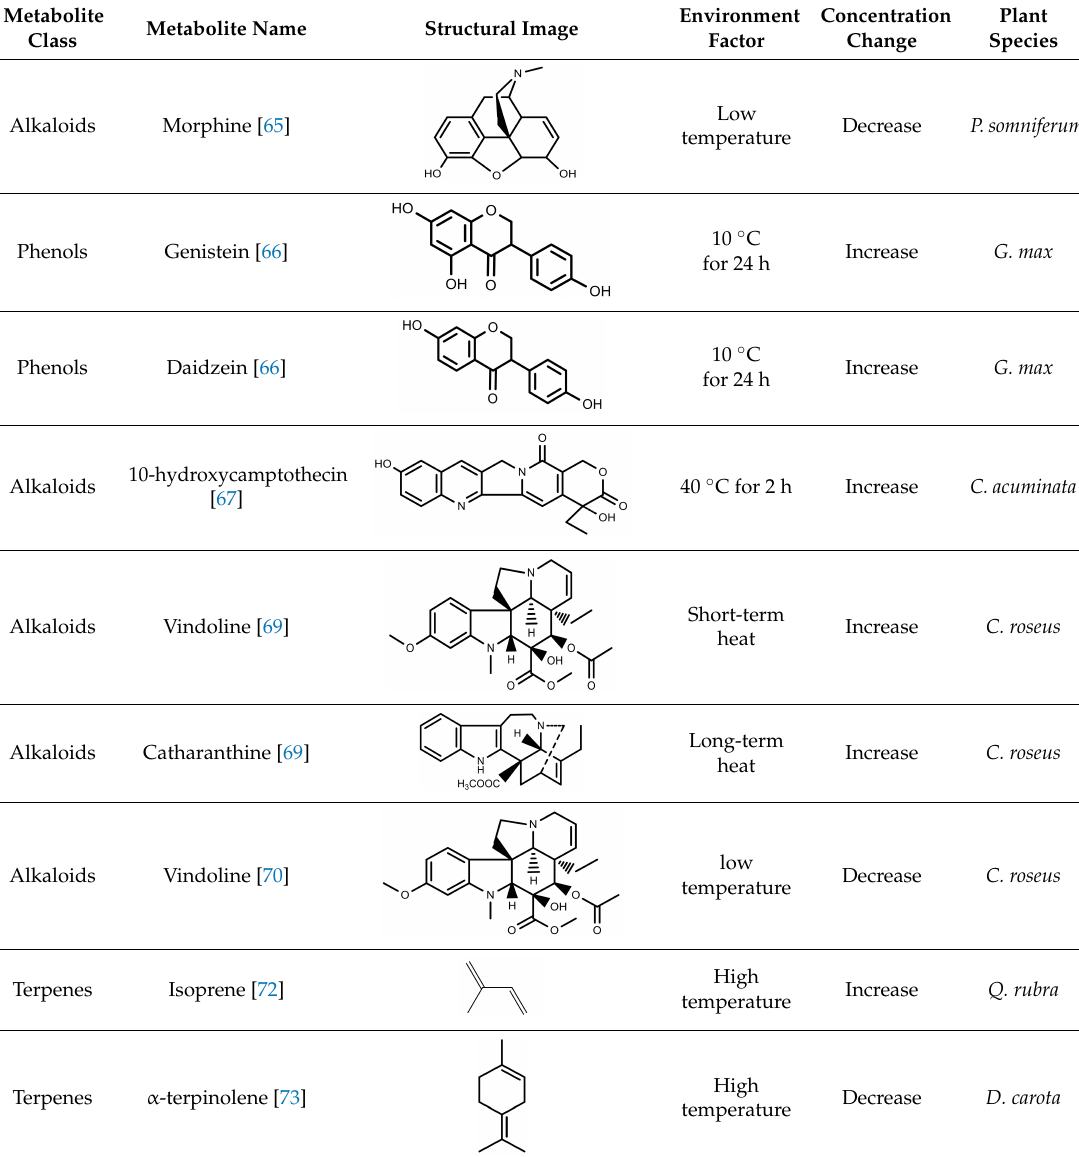
Table 4. Temperature change on the content of various plant